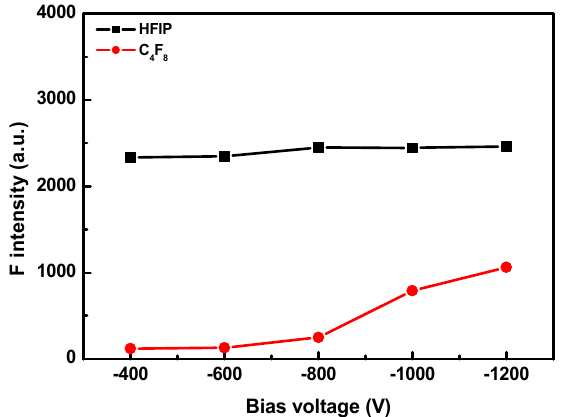
Figure 5. Optical emission intensities of fluorine radicals in HFIP/Ar and C 4 F 8 /Ar plasmas as a function of the bias voltage.